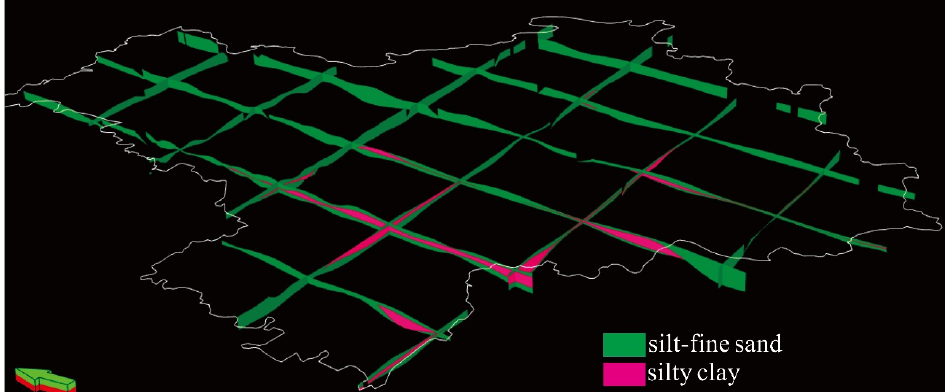
Figure 7. Distribution of the upper fine-grained sand and the inside lenses.